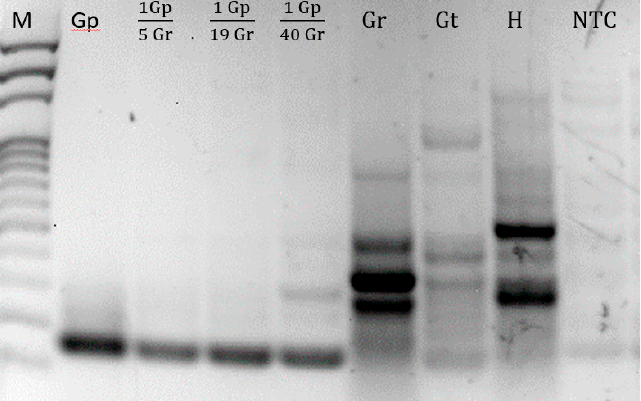
Figure 3. Agarose gel of the amplified products obtained with asymmetric PCR using F3 and b-B2 primers. M = 100 bp DNA Ladder (Thermo Scientific); Gp = Globodera pallida .; Gp/Gr = ratios of G. pallida and G. rostochiensis ; Gr = G. rostochiensis ; Gt = G. tabacum ; H = Heterodera sp.; NTC = negative control (no DNA template).